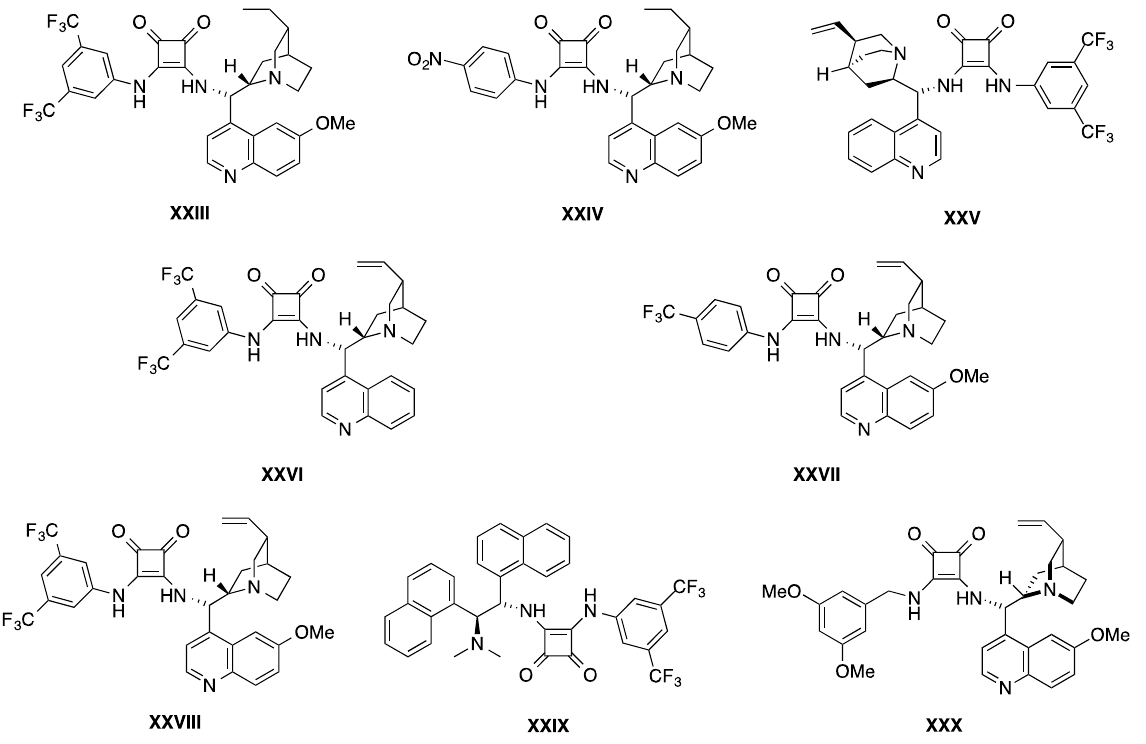
Figure 6. Squaramide based organocatalysts reported in the present section.